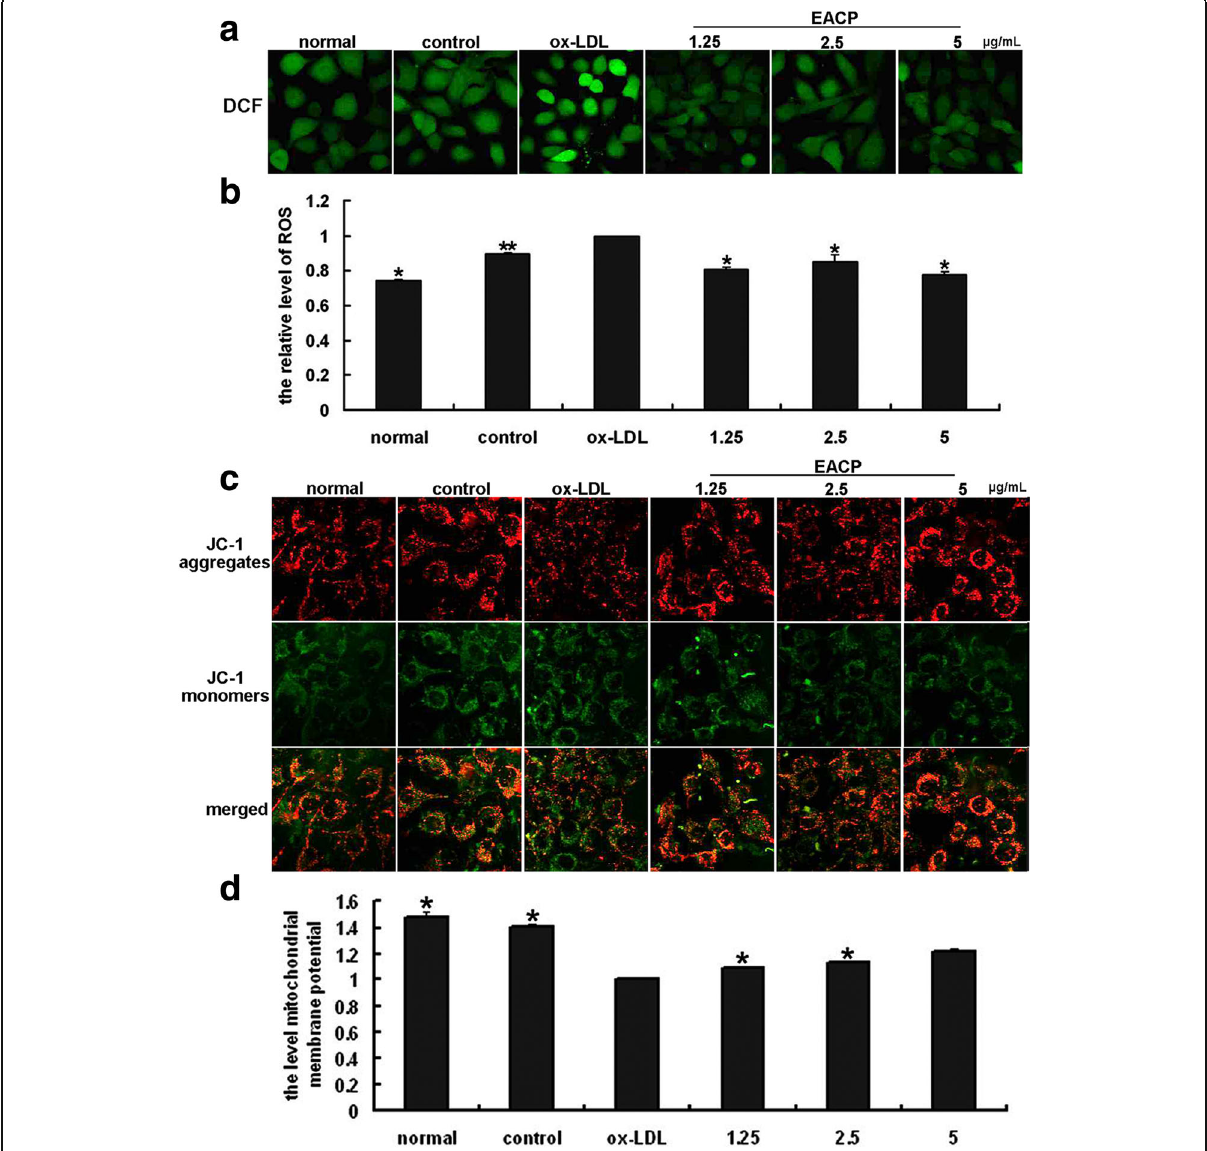
Fig. 6 EACP decreased the production of ROS and protect mitochondrial membrane potential (MMP) in ox-LDL induced HUVECs. a , Fluorescent micrographs of ROS obtained in ox-LDL induced HUVECs at 6 h. b , Quantification of relative quantity of ROS in ox-LDL induced HUVECs at 6 h. Values represent the relative fluorescent intensity per cell determined by laser scanning confocal microscopy. c , Fluorescent micrographs of mitochondrial membrane potential obtained in ox-LDL induced HUVECs at 6 h. d , Quantification of relative fluorescent intensity per cell determined by laser scanning confocal microscopy. Values represent as ratio of red to green fluorescence. ( * P < 0.05, ** P < 0.01 vs ox-LDL group, n = 3). Data are means ±